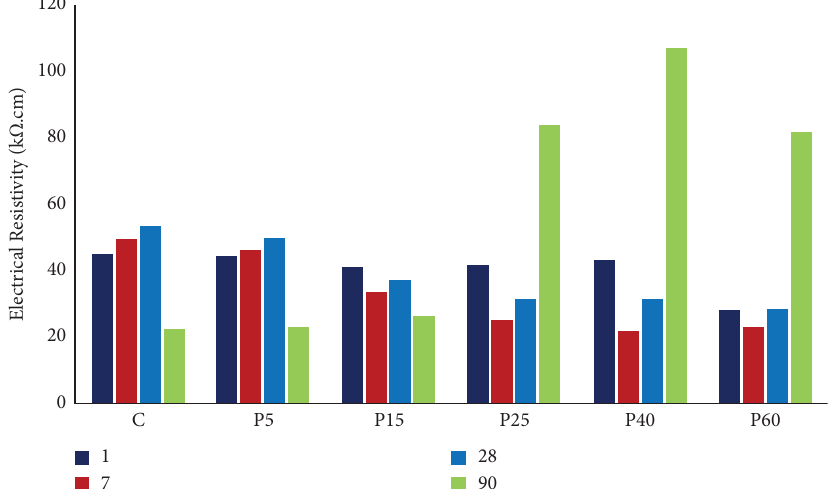
Figure 11: Electrical resistivity values of the pumice mixtures.